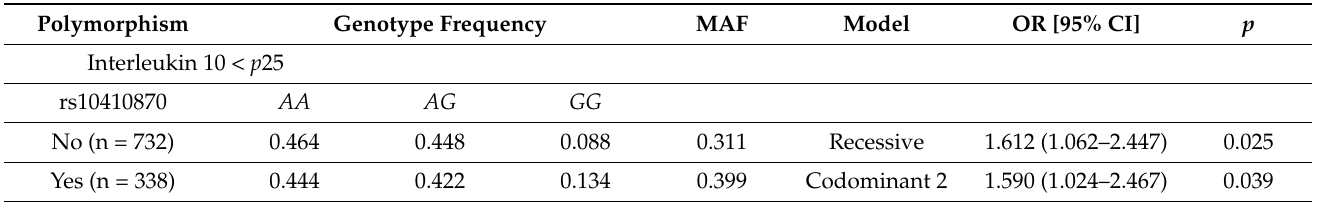
Table 3. Association of FOXA3 polymorphisms with metabolic risk factors in healthy